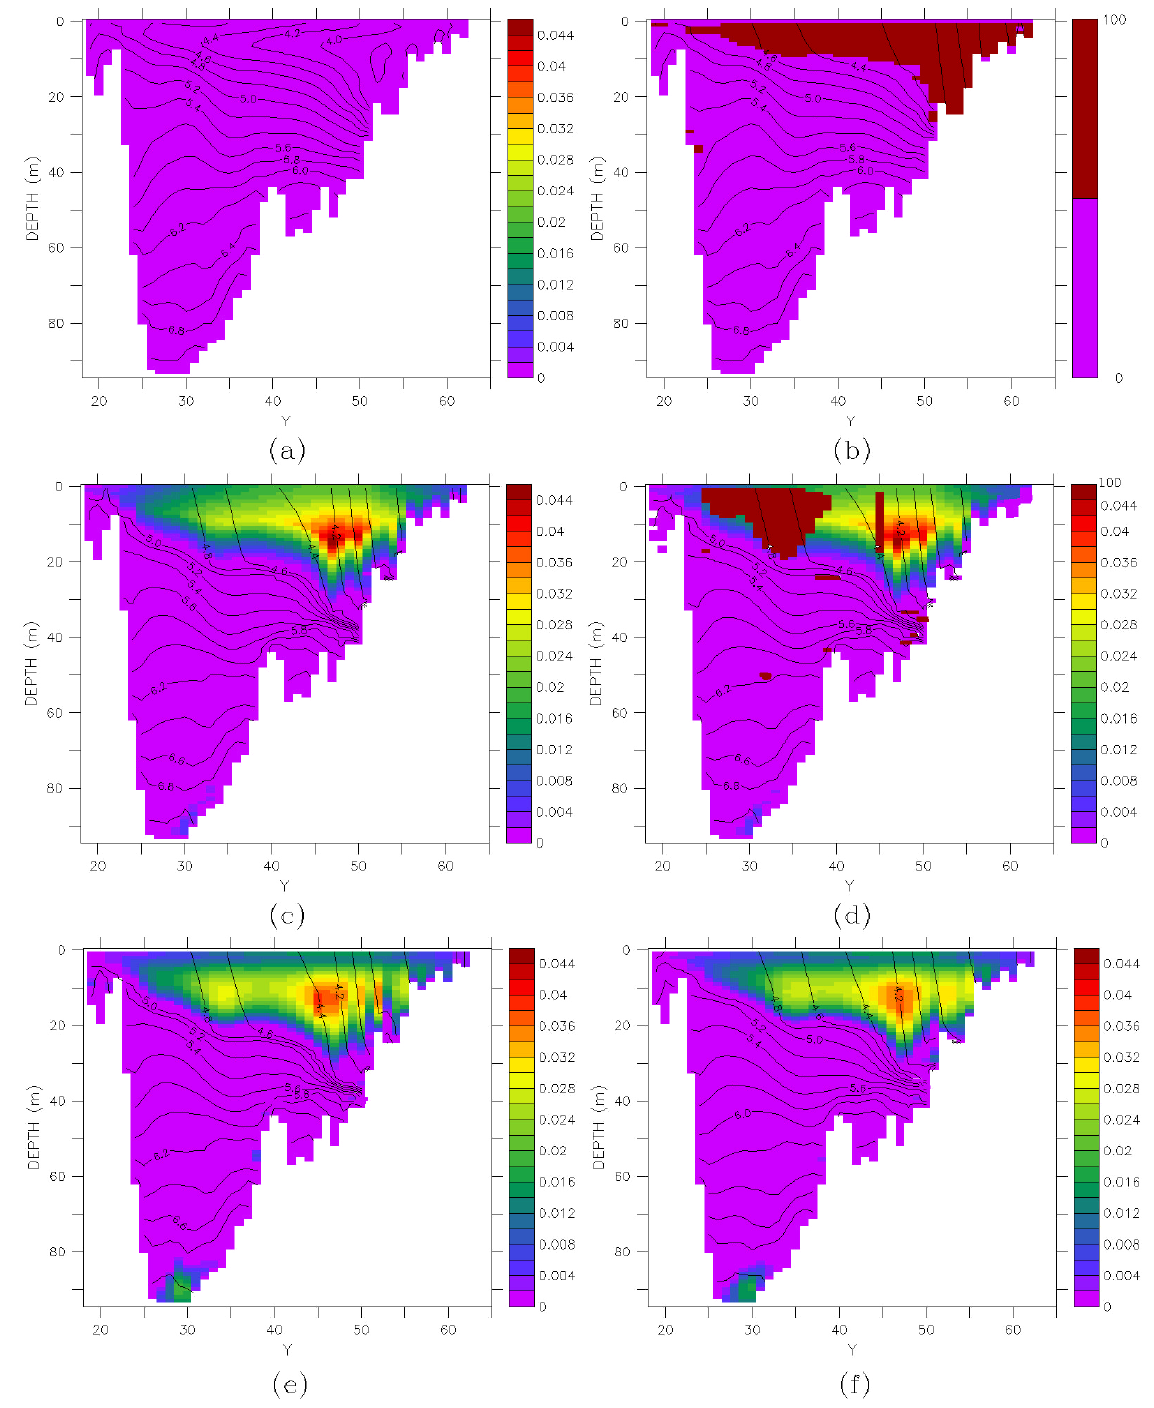
Figure 2. Meridional cross section of the GOF at 25.5 ◦ E. Vertical eddy diffusivity coefficient (shaded surface) overlaid by density isolines: (a) constant vertical eddy viscosity/diffusivity coefficients set to the 10 − 4 / 10 − 5 m 2 s − 1 , (b) convective adjustment only (ED), (c) TKE, (d) TKE + ED, (e) GLS with a Galperin limit set to 0.53, (f) GLS with a Galperin limit set to